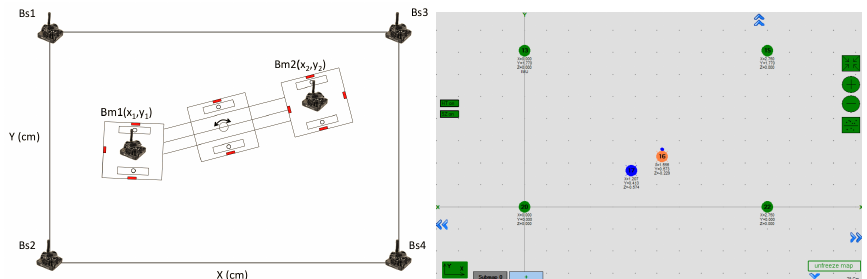
Figure 10. Beacon positions: The Bss are the static beacons and the Bms are the mobile beacons mounted on the Mantis v2 in the left panel; in the right panel, the position of the beacons is shown in the MarvelMinds software: Static in green, and mobile in blue and